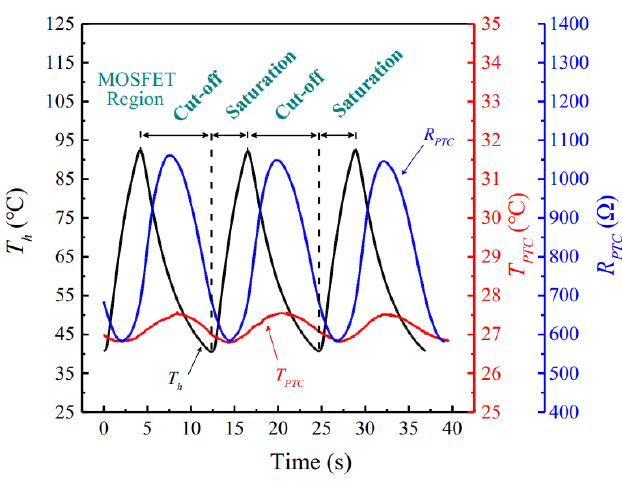
Figure 8. Transient behavior of the proposed device.